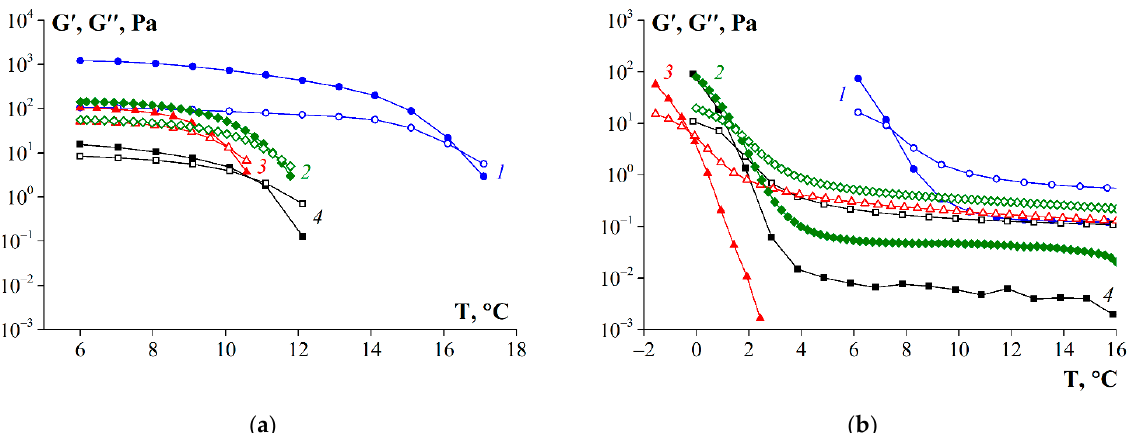
Figure 6. Storage (G ′ , closed symbols) and loss (G ″ , open symbols) modulus’s dependency on temperature obtained during the heating ( a ) and cooling ( b ) at ω = 6.28 and γ = 1 %·rad/s. Scanning rate was 1 ° С /min. 1—G1, 2—G2, 3—G3, 4—G 7041. Gelatin concentration was 10 wt.%.